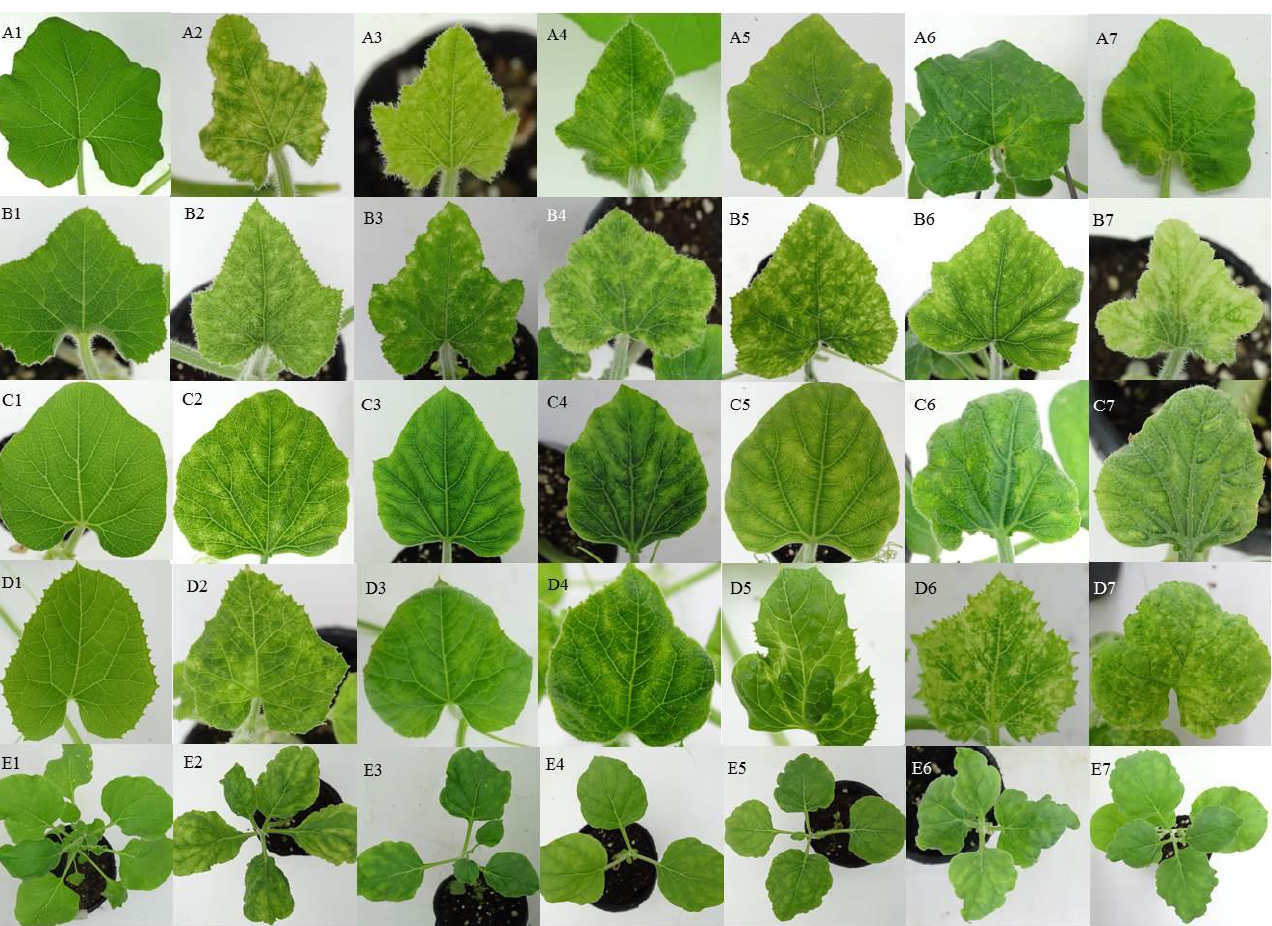
Figure 2 . Symptoms on agroinoculated host plants with infectious DNAs cucurbit-infecting begomoviruses. Symptoms were induced by agroinoculation with Agrobacterium tumefacies LBA4404 that contained infectious DNA-A and DNA-B of SLCuPV-A[PH-BoG137-18] ( A2 – E2 ), -A[PH-Pk212-41-19] ( A3 – E3 ), -B[PH-Pk76-18] ( A4 – E4 ) and -B[PH-BoG216-18] ( A5 – E5 ). SLCCNV-A[PH-Pk195-18] DNA-A ( A6 – E6 ) and SLCCNV-A[PH-Pk212-42-19] DNA-A ( A7 – E7 ) were co-inoculated with a previous SCLCCNV-[MY-Sq3-5-16] DNA-B [15]. ( A1 – E1 ) were the symptomless plants, pumpkin ( Cucurbita maxima ), Chinese squash ( C. moschata ), bottle gourd ( Lagenaria siceraria ), melon ( Cucumis melo ) and tobacco ( Nicotiana benthamiana ) agroinoculated with pCAMBIA0380. Symptomatic plants, pumpkin ( A2 – A7 ), Chinese squash ( B2 – B7 ), bottle gourd ( C2 – C7 ), melon ( D2 – D7 ) and